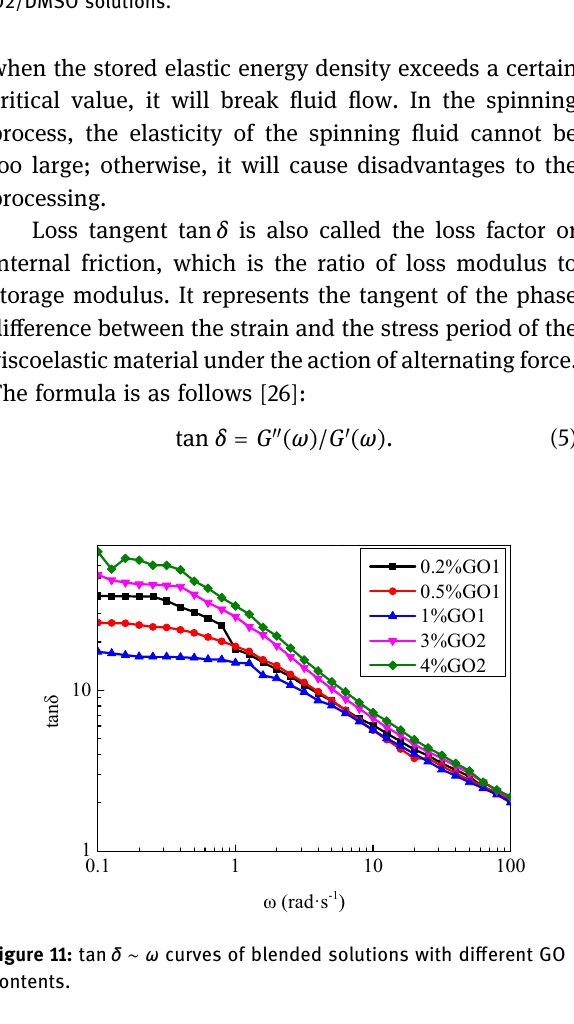
Figure 10: ( a ) G ′ ∼ ω , G ″ ∼ ω curves of PAN/GO1/DMSO and ( b ) PAN/GO2/DMSO